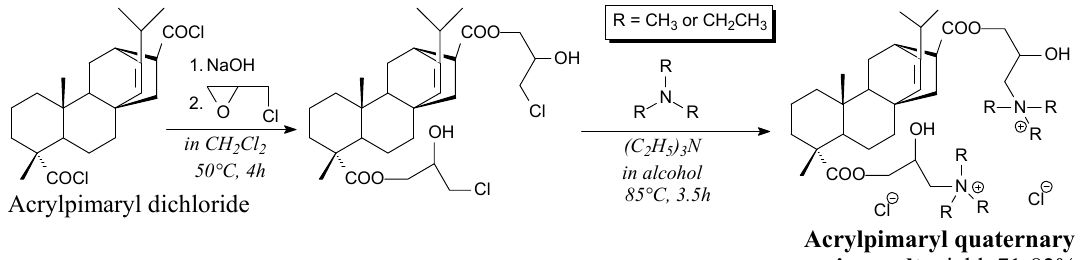
Scheme 42. Synthesis of acrylpimaryl quaternary ammonium